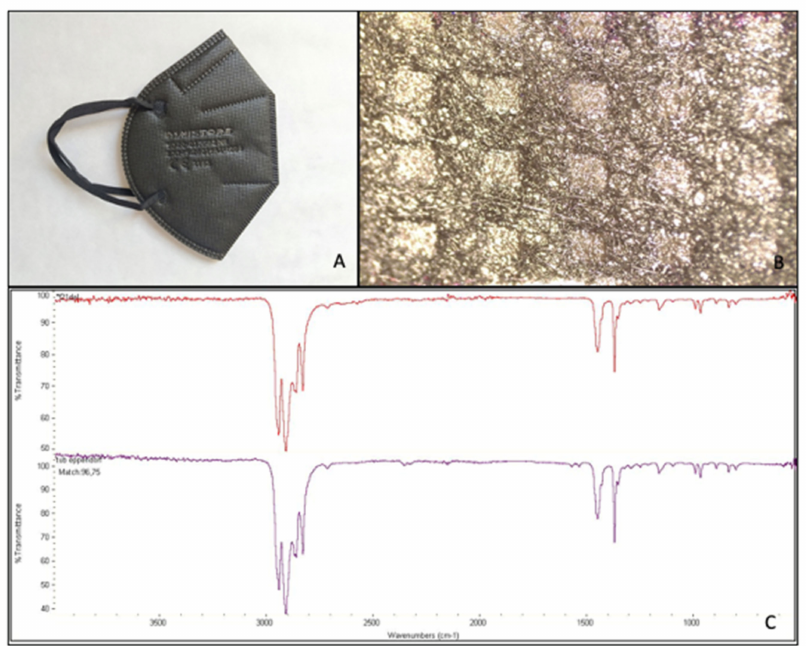
Figure 3. Facial mask FFP2 N studied ( A ); structure after disassembling in layers (500 µ m scale bar) ( B ); and mask spectrum (at the top), spectrum listed in the library (at the bottom) identifying polypropylene, atactic, 96.75% ( C